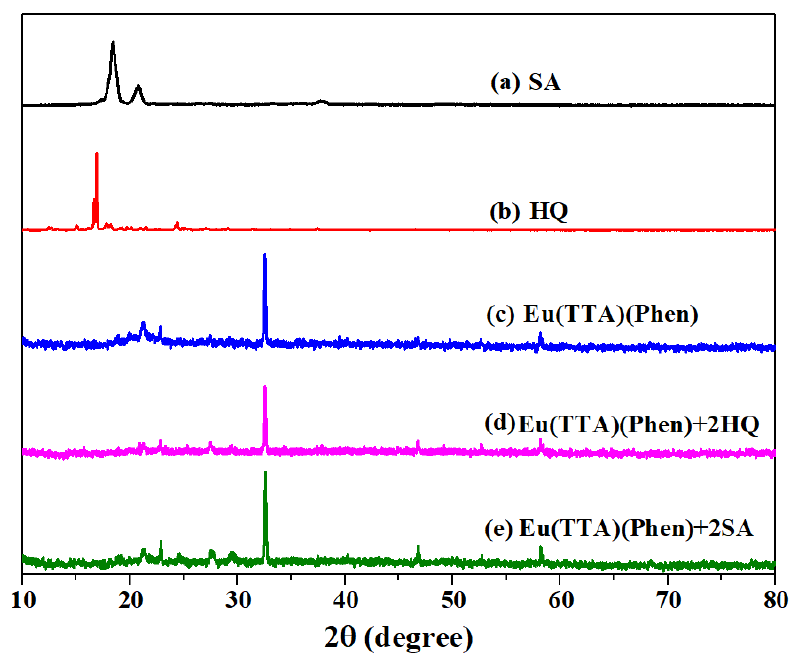
Figure 2. XRD patterns: ( a ) SA, ( b ) HQ, ( c ) ETPC, ( d ) ETPC-SA, and ( e ) ETPC-HQ.